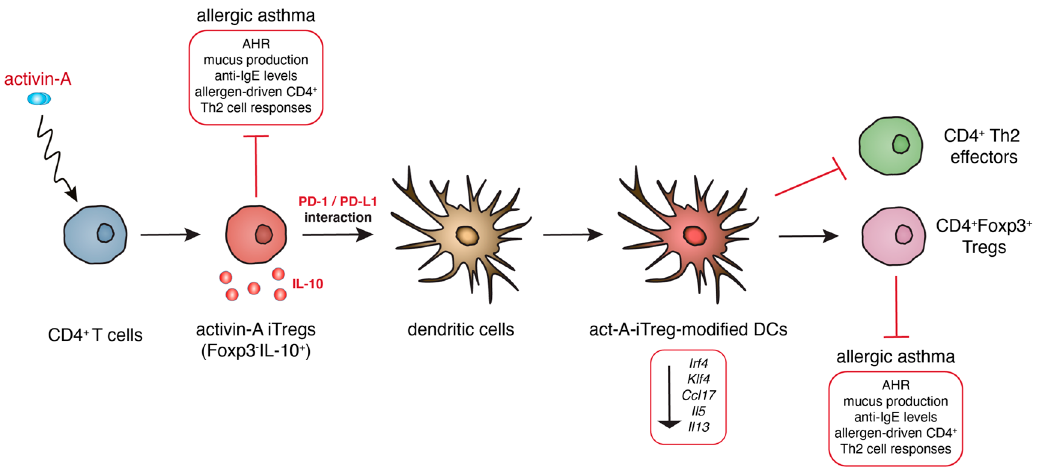
Figure 3. Act-A-iTreg-modified DCs control allergic asthma through the instruction of CD4 + Foxp3 + regulatory T cells.